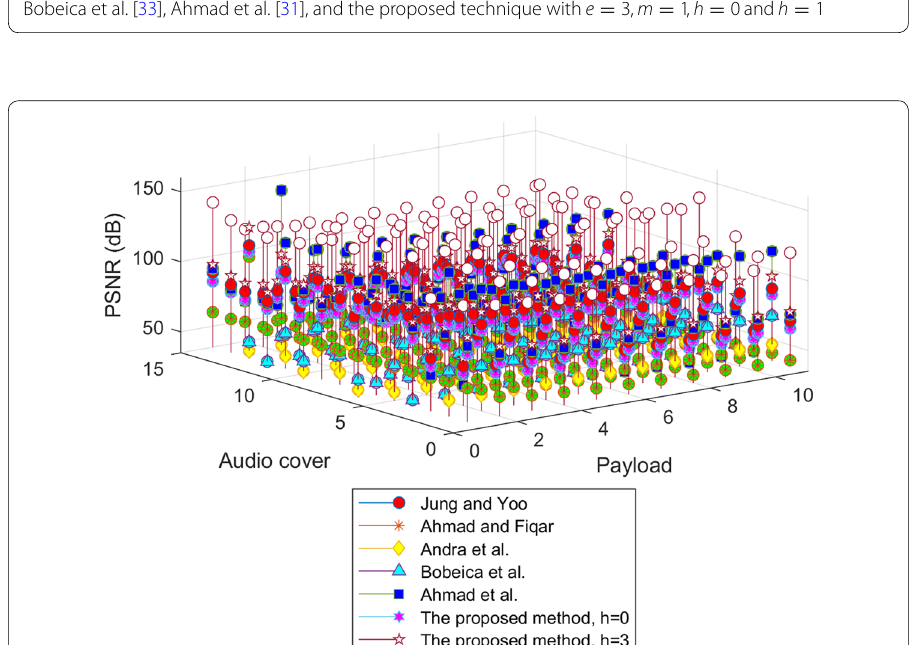
Fig. 10 The quality of the stego file generated by Jung and Yoo [29], Ahmad and Fiqar [30], Andra et al. [32], Bobeica et al. [33], Ahmad et al. [31], and the proposed technique with e = 3 , m = 1 , h = 0 and h =